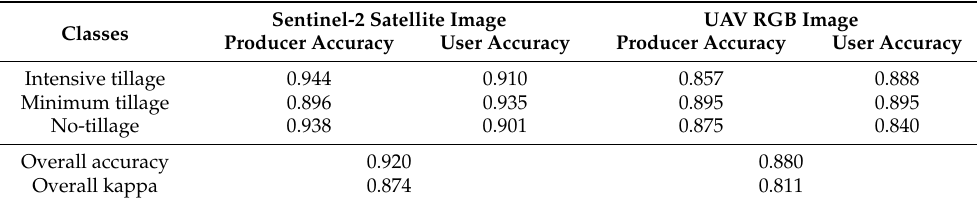
Table 5. Evaluation of the Fuzzy OBIA method of the classification for the both of UAV and Sentinel-2 platforms using confusion